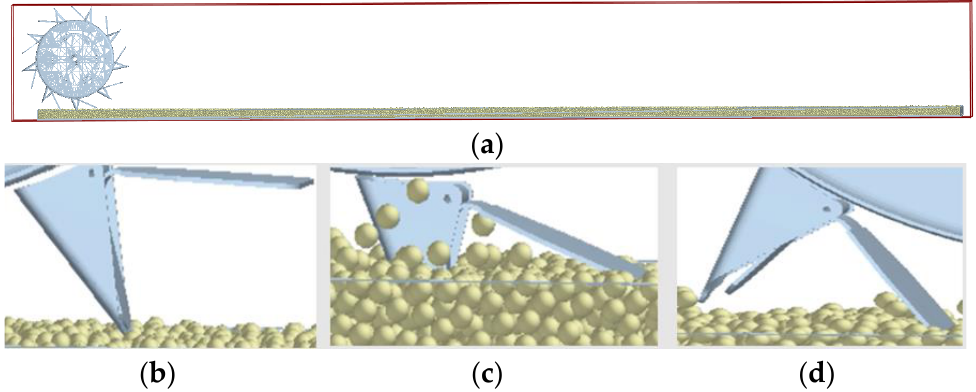
Figure 11. Co-simulation results of EDEM and RecurDyn. ( a ) Schematic diagram of the overall